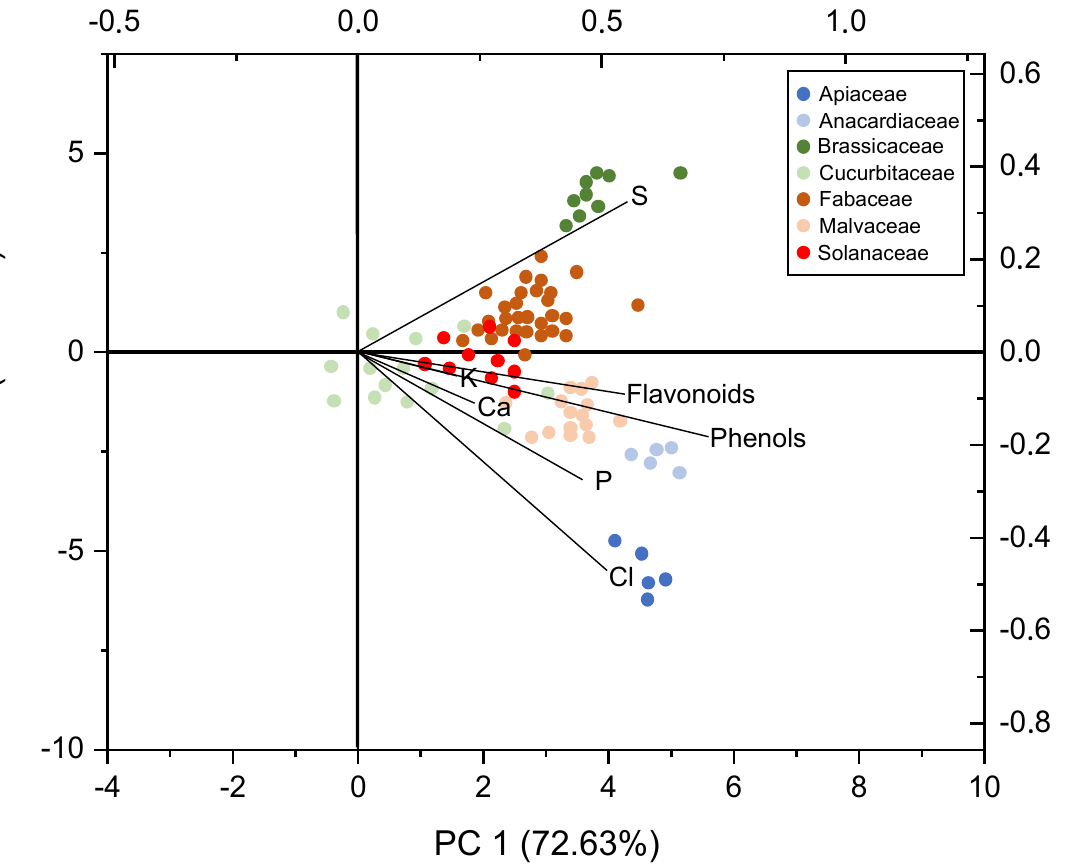
Figure 3. Principal component analysis of mineral and phytochemical contents.